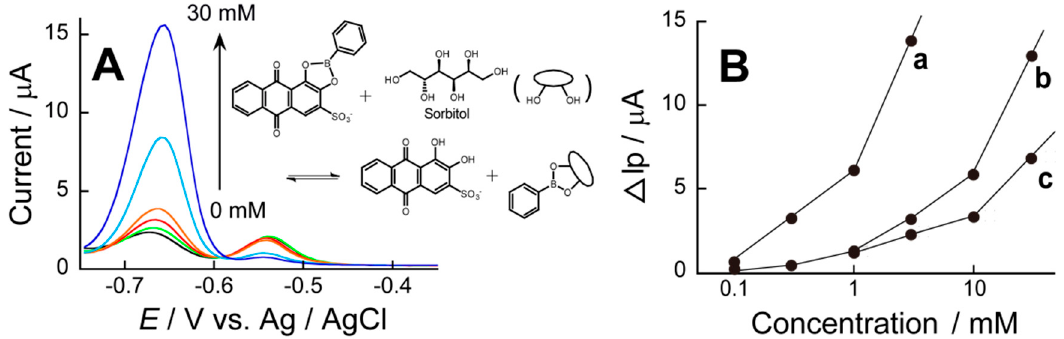
Figure 7. ( A ) DPVs of the ARS-confined (PBA-PEI/CMC) 10 PBA-PEI film-coated electrodes in the presence of sorbitol and the binding equilibrium between ARS-PBA and sorbitol (inset); and ( B ) changes in the intensity of peak current in DPVs at ca. − 0.67 V as a function of the concentration of L-dopa (a); sorbitol (b); and glucose (c). ∆ Ip denotes the peak current around − 0.67 V increased in the presence of L-dopa, sorbitol, and glucose. DPVs were recorded at pH 9.0.